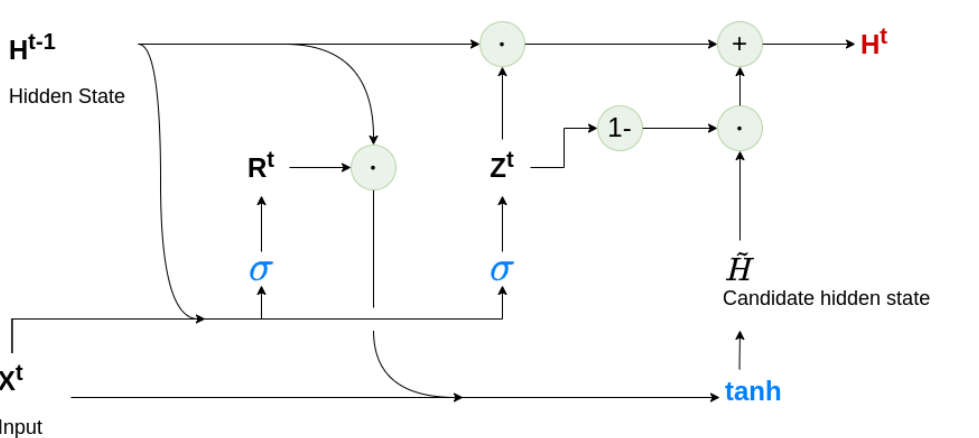
Figure 5. The architecture of a single GRU cell where: H t − 1 = previous hidden state; R = Reset gate = σ ( x t ) · Wx + H t − 1 · Whr + br ; Z = Update gate = σ ( x t ) · Wxz + H t − 1 · Whz + bz ; H = Hidden state = tanh ( x t · Wxh ) + ( R · H t − 1 ) · Wh ; ˆ y = Output = H t + Whq + bq